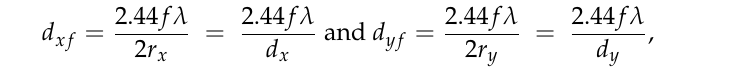
Figure 3. Effects of ( a ) e and ( b ) φ on Δ θ x .